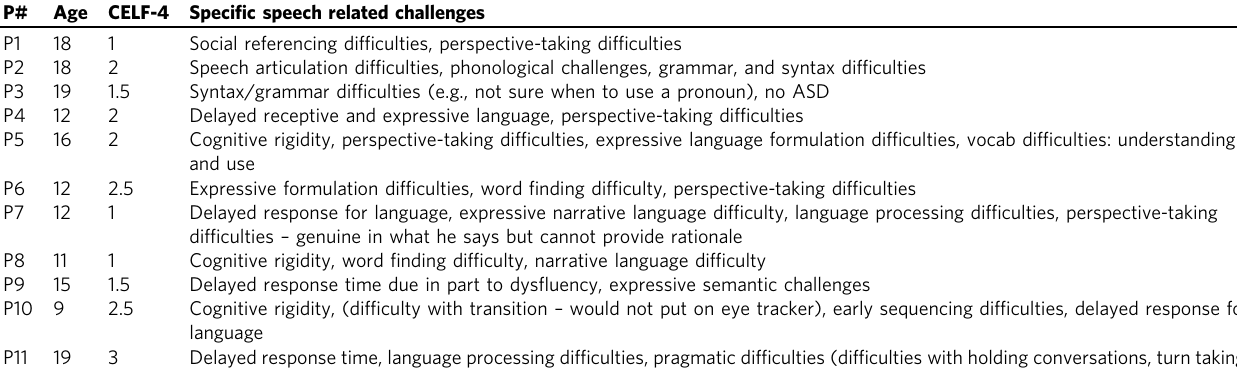
Table 1 Participant demographics: age, social pragmatic score and